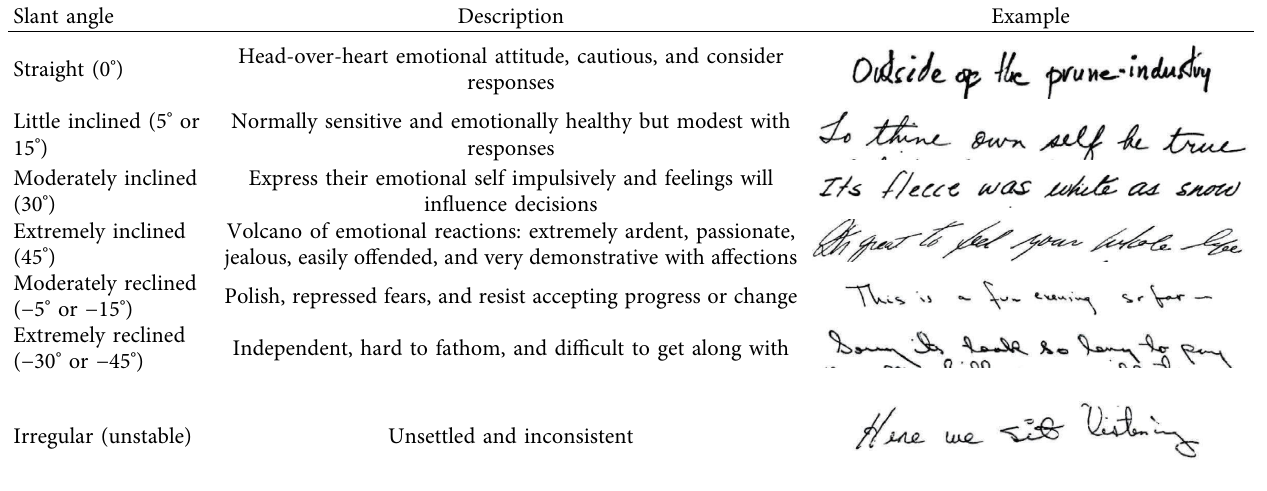
Table 8: Te slant features and their corresponding types.